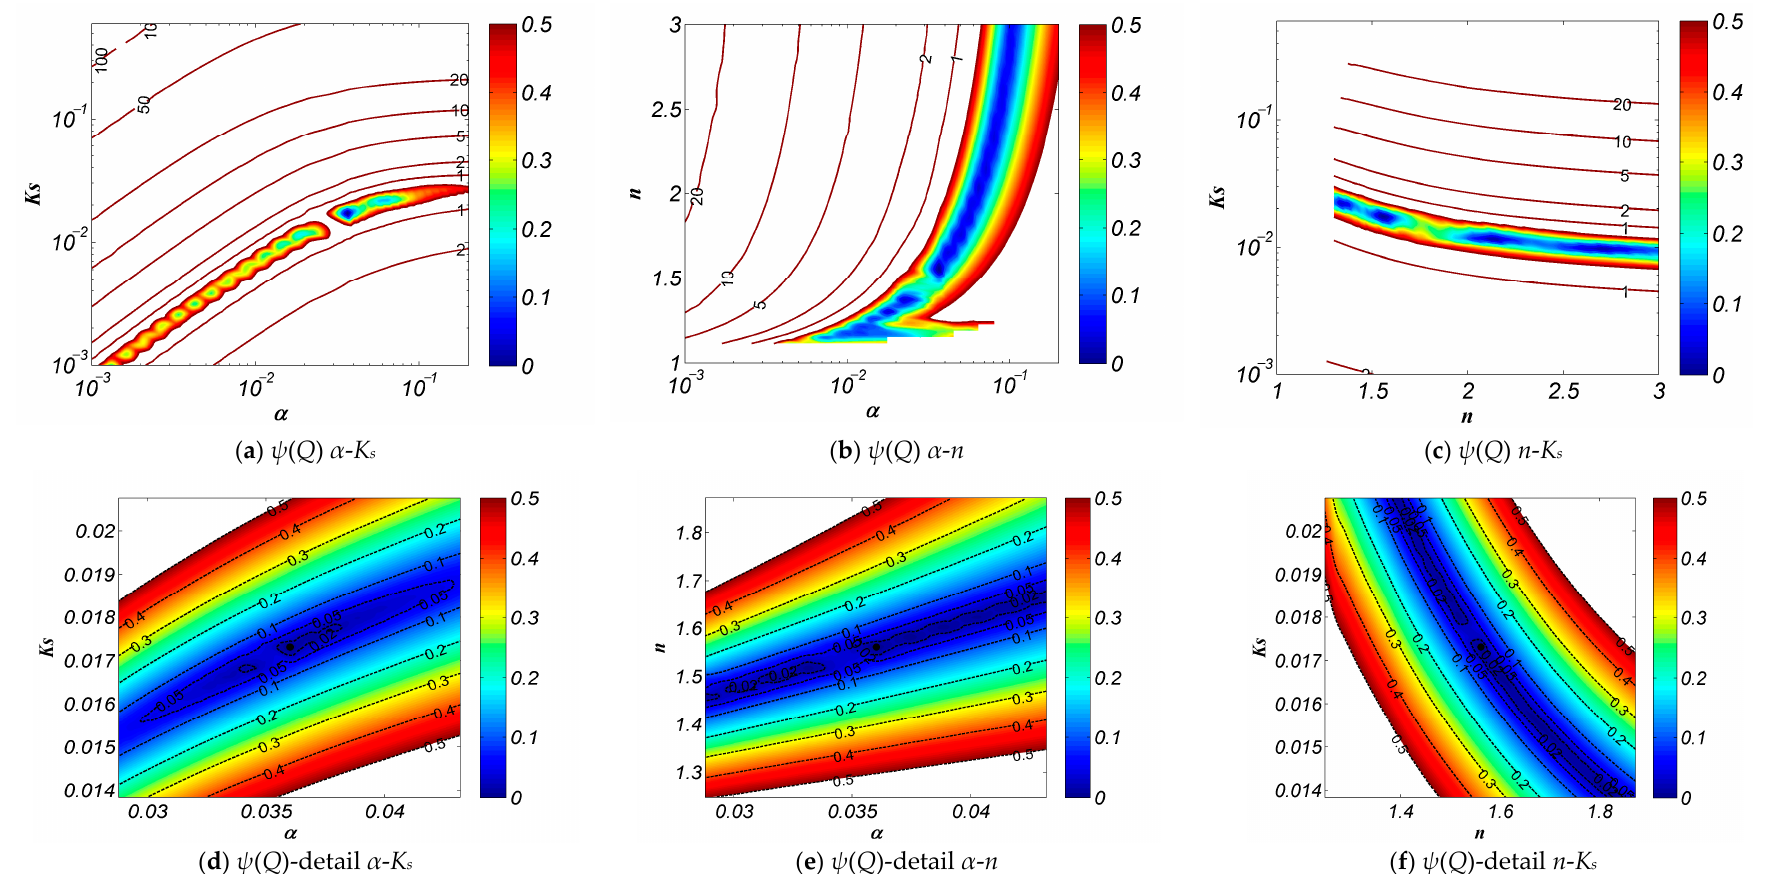
Figure 6. Contours of the objective function ψ ( Q ) of loam with θ initial as 40% effective saturation. The hydraulic parameters of loam: K s = 0.0173 cm · min − 1 ; n = 1.56; α = 0.036 cm − 1 ; θ s = 0.43 cm 3 ·cm − 3 ; θ r = 0.078 cm 3 ·cm − 3 . Results are plotted in the parameter planes of ( a , d ) α - K s , ( b , e ) α - n , and ( c , f ) n - K s . The global scale is depicted in ( a – c ), while the local scale near the minimum is depicted in ( d – f ).